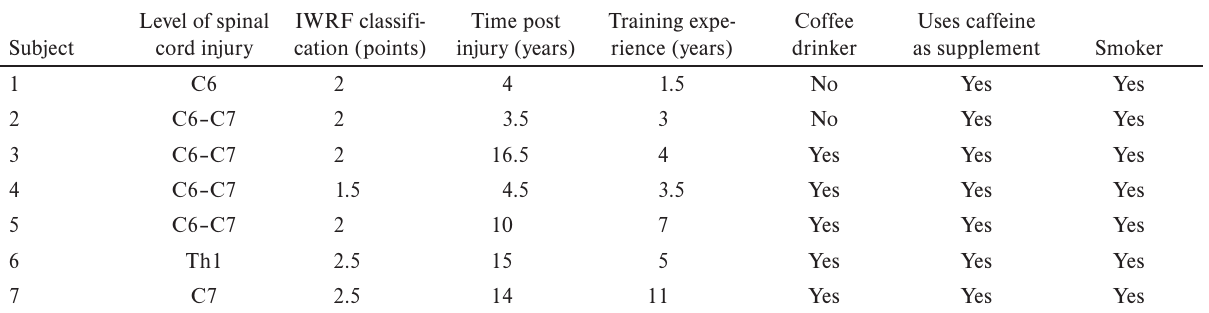
Disability and other evaluated